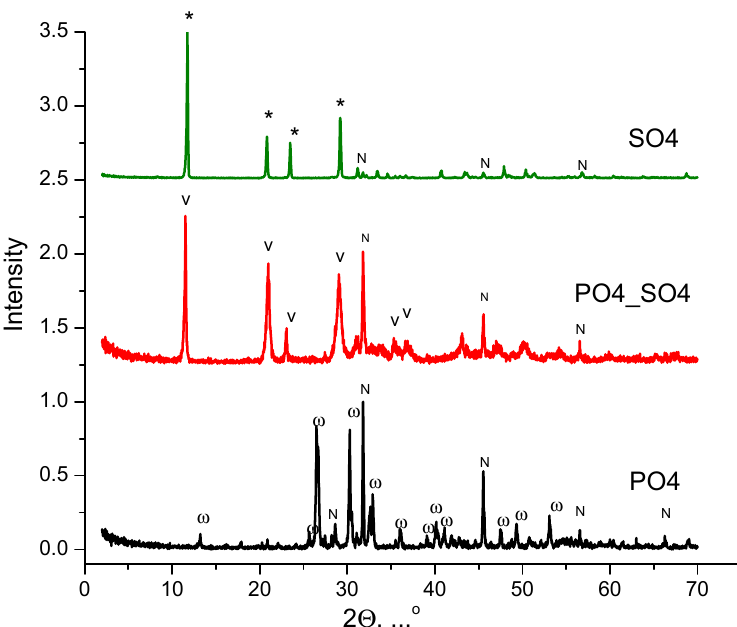
Figure 3. XRD data of powders synthesized from aqueous solution of calcium chloride CaCl 2 and sodium sulfate Na 2 SO 4 (green line); from aqueous solution of calcium chloride CaCl 2 and sodium hydrophosphate Na 2 HPO 4 (black line); and from aqueous solution of calcium chloride CaCl 2 and mixed-anionic solution Na 2 HPO 4 /Na 2 SO 4 (red line) after disaggregation in acetone: *—CaSO 4 ·2H 2 O (card PDF 21-816); N—NaCl (card PDF 5-628); v—Ca(HPO 4 ) х (SO 4 ) 1 −х ·2H 2 O (PDF card 46-657); Ca(HPO 4 ) 0.5 (SO 4 ) 0.5 ·2H 2 O (Match card 96-900-0654); ω —CaHPO 4 ( карточка PDF 9-80). Table 3. Composition of synthesized powders after disaggregation, wt. %.